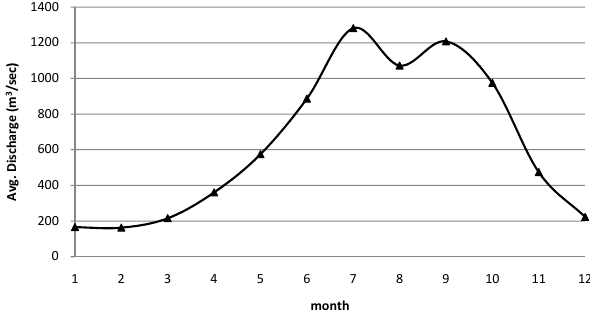
Fig. 3. Average monthly streamflow hydrographs of headwaters region of the Yellow River.